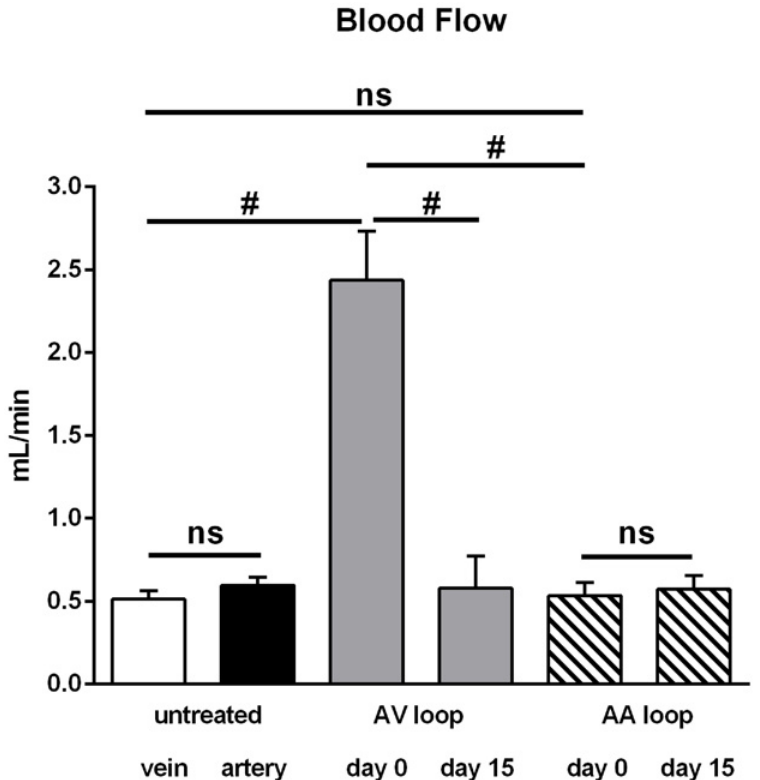
Fig 3. Mean blood flow in untreated vessels, arterioarterial (AA) and arteriovenous (AV) loops. In untreated femoral arteries and veins (each n = 28) flow was similar. Flow through a loop created by interposition of a vein graft into the arterial flow pathway (AA) was not different from untreated vessels immediately after surgery (day 0, n = 7) and remained at this level until explantation (day 15, n = 4). In contrast, mean blood flow through AV loops was substantially enhanced at day 0 (n = 27), but attained the level of untreated vessels at day 15 (n = 11). All values are mean+/-SEM. #: P < 0.001 vs. other groups.